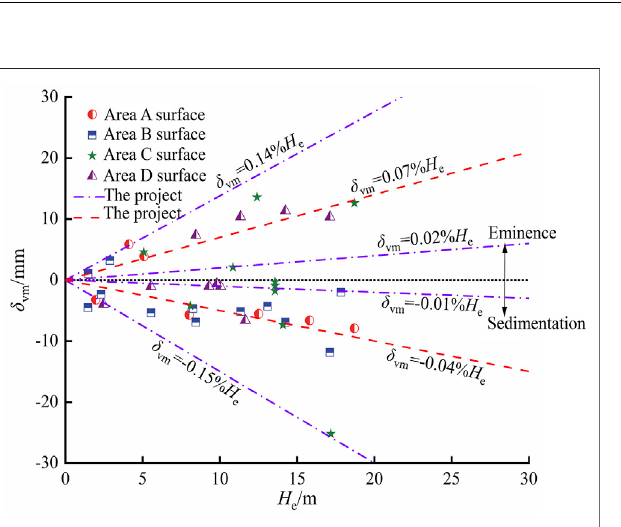
FIGURE 7 | Relationship between δ vm and H e